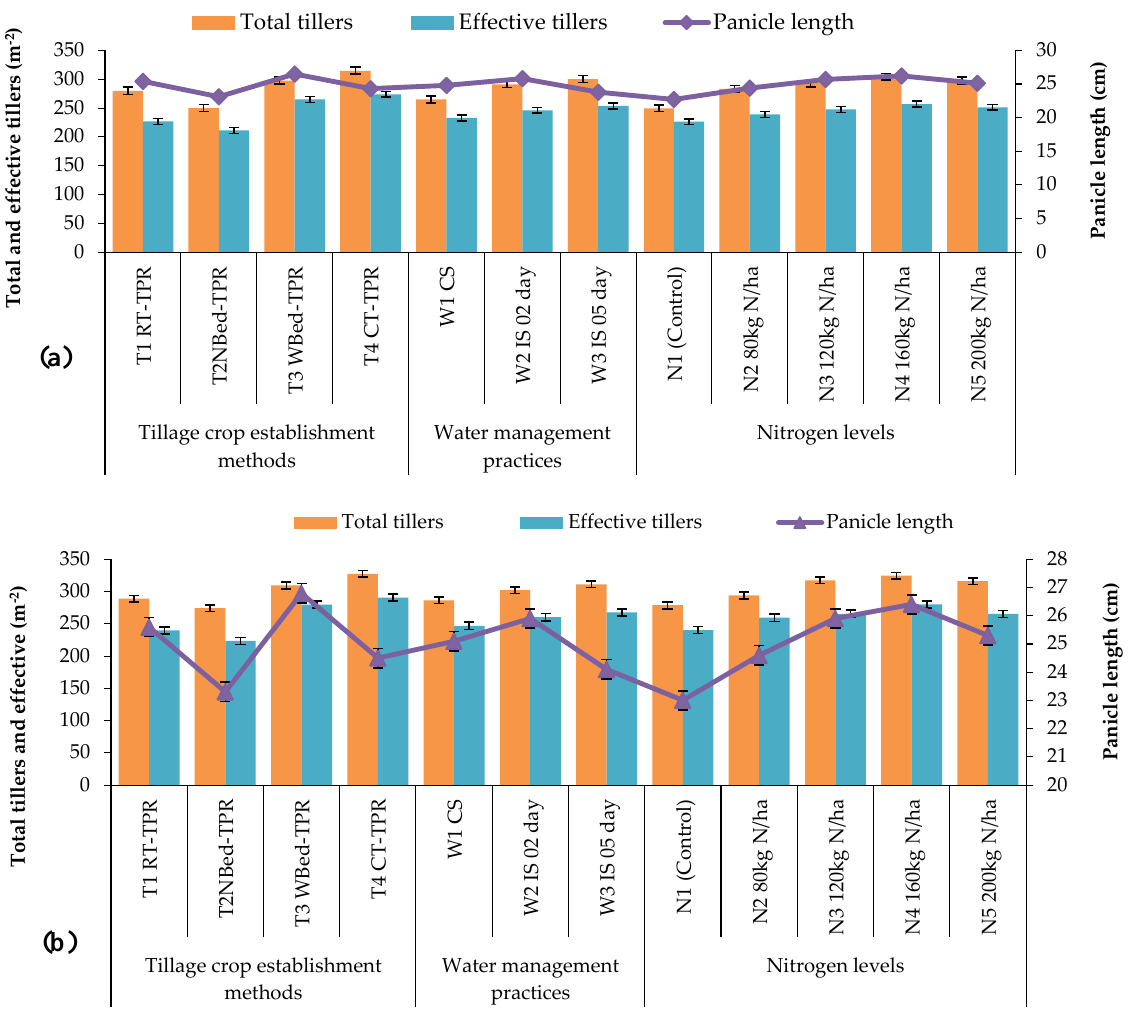
Figure 4. Interactive effects of tillage, water and nitrogen on total and effective tillers and panicle length of rice in both years: ( a ) 2016 and, ( b ) 2017.